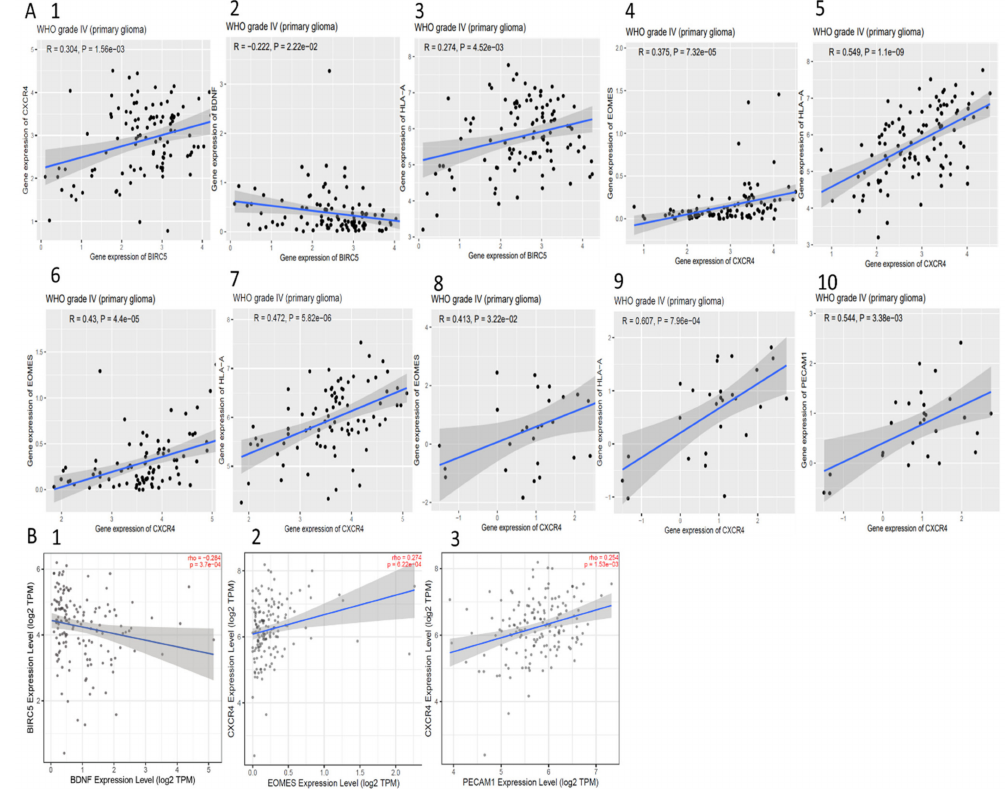
Figure 8. Coexpressions of BIRC5 and CCR4 with each other and with the methylated genes from CGGA and TIMER (for TCGA). ( A ) ( 1 – 5 ) mRNA_693, ( 6 , 7 ) mRNA_325, ( 8 – 10 ), and mRNA_Array_301 show the significant ( p < 0.05) correlation between the genes from timer, ( B ) ( 1 – 3 ) shows the significant ( p < 0.05) correlation from